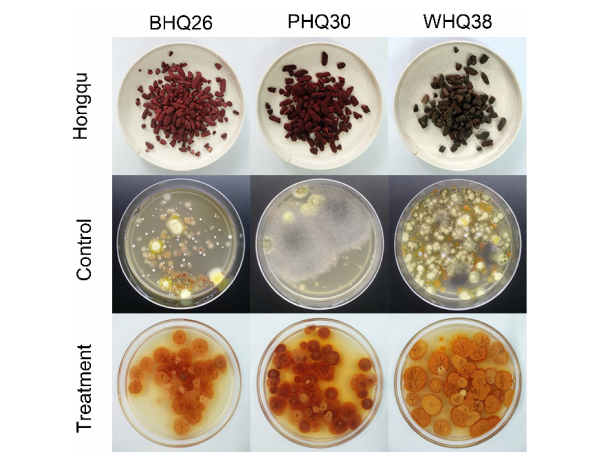
FIGURE 9 | Application of the optimized restricted medium for enrichment of Monascus from different Hongqu. The direct dilution coating method (control group) and the fermentation-coating method (treatment group) were used to separate Monascus from three Hongqu, respectively. Among them, BHQ26 is a Hongqu for rice wine brewing, PHQ33 is a Hongqu for pigment production, WHQ38 is a special Hongqu for rice wine brewing that contains more Aspergillus niger than other